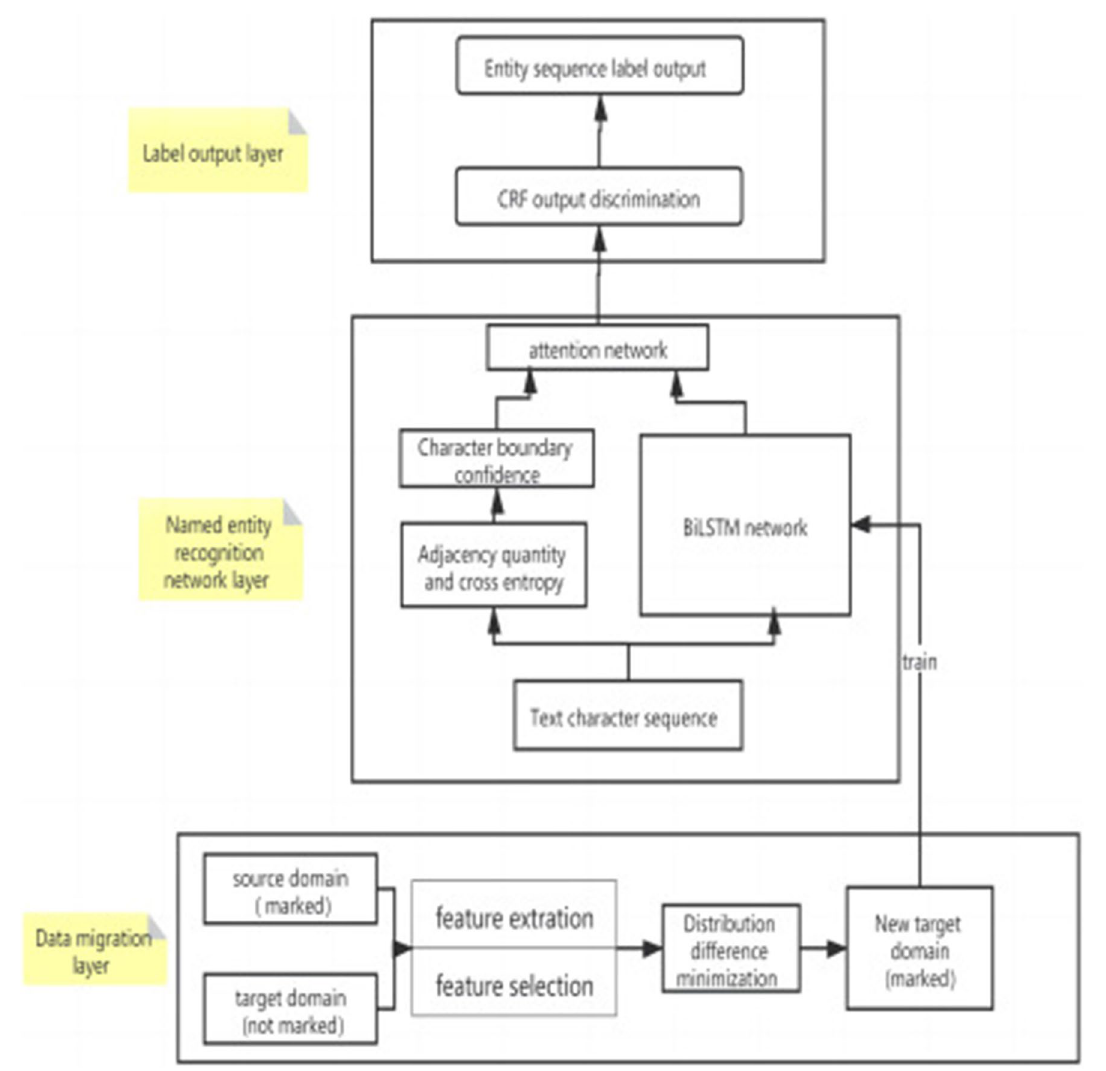
Fig. 1 Framework of Chinese named entity recognition model based on Transfer